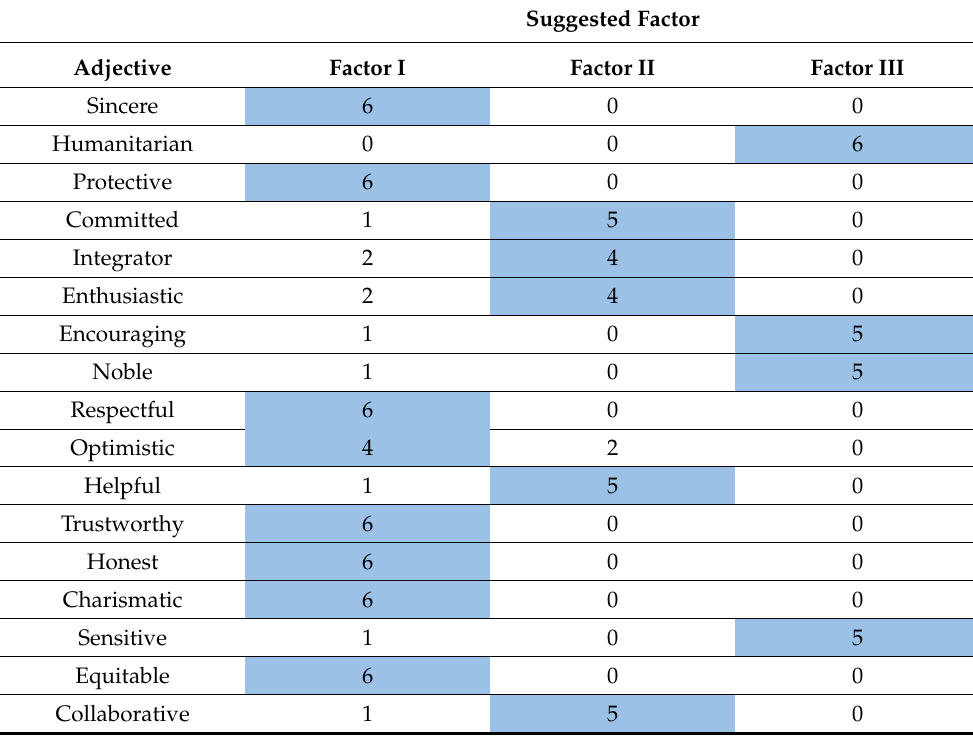
Table 5. Suggested factors from factorial scenarios (three